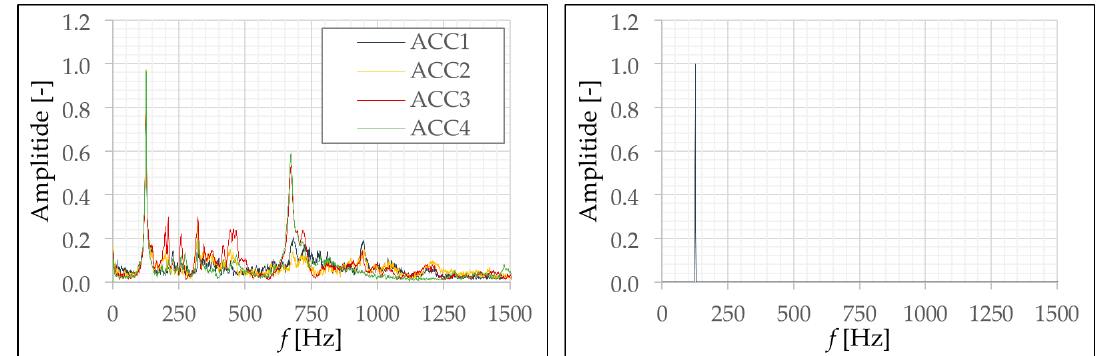
Figure 12. Amplitude-frequency diagram resulting from FFT ( left ) and amplitude-frequency diagram modified with Equation (6) ( right ); graphic: M. Hering [17]. Table 5. Measured eigenfrequencies for each stimulation f E,Stx and global damage Φ global ; Hering [17].